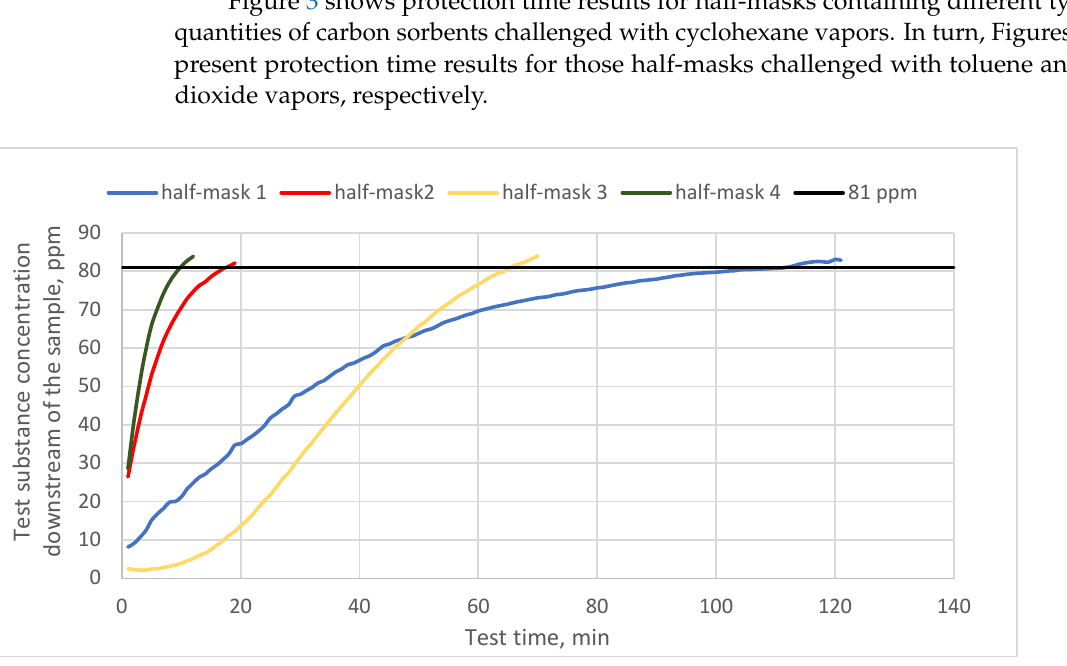
Figure 3. Protection time against cyclohexane for half-masks incorporating different types and quantities of carbon sorbents.